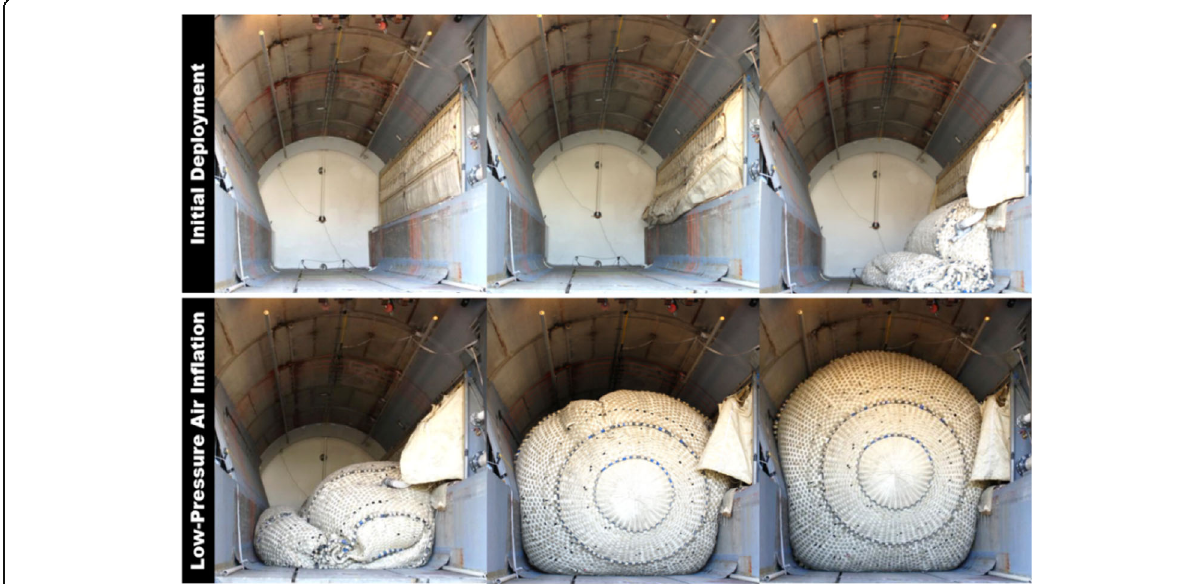
Fig. 10 Phase 2b-ET, full-scale testing, and three-layer Vectran plug. A sequence of initial deployment from softcover container followed by low- pressure air inflation before flooding simulation [69,